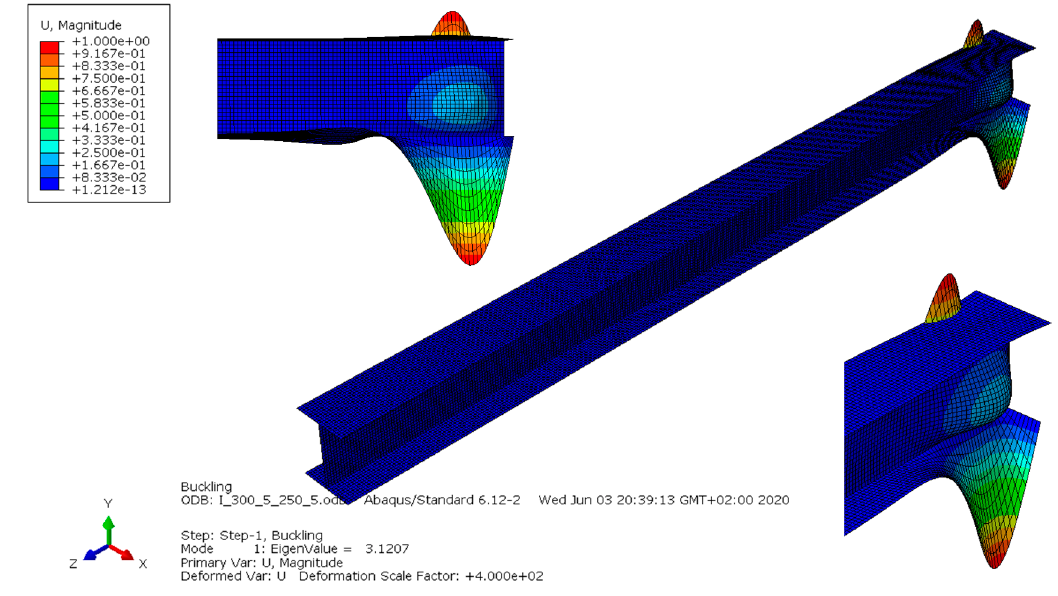
Figure 7. Local buckling of I-300 × 5 × 250 × 5 beams in the support zone.